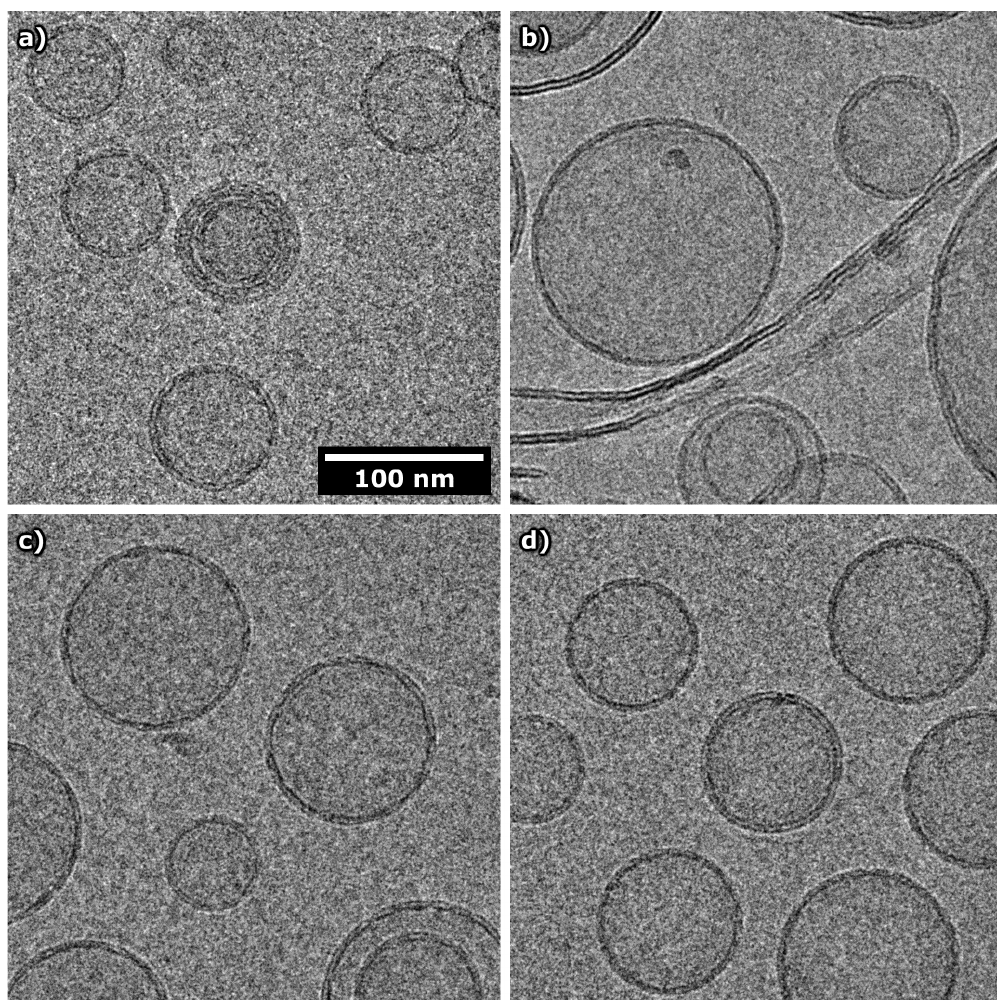
Figure 9. Representative cryo-TEM images of ( a , b ) POPC and ( c , d ) 3:1 POPC:POPS vesicles in the ( a , c ) absence and ( b , d ) presence of KEIF, at 10mM NaF in TRIS buffer. The lipid:KEIF molar ratio was 16:1. The scale bar applies to all